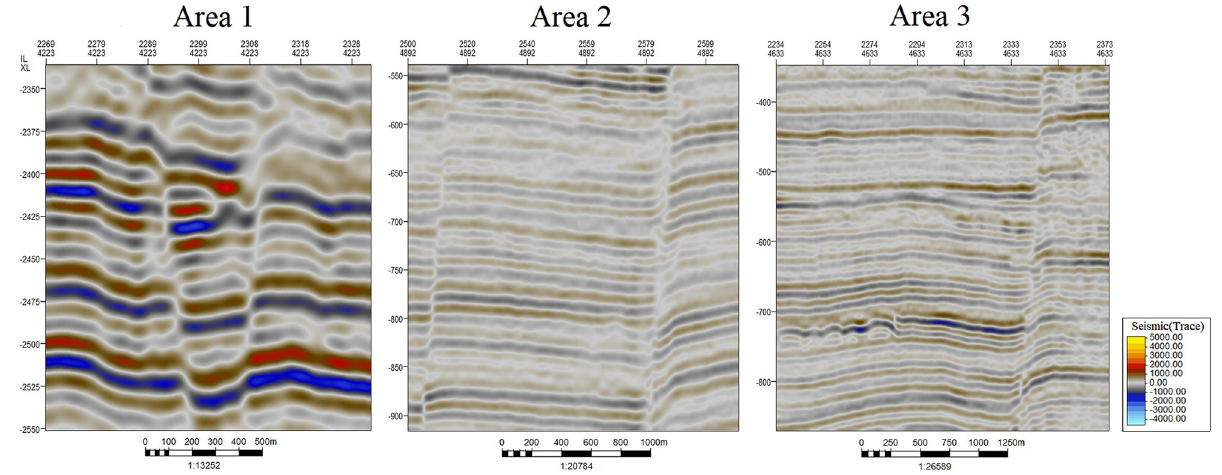
Fig 1. Test SEG-Y seismic data of different scales used in this paper.